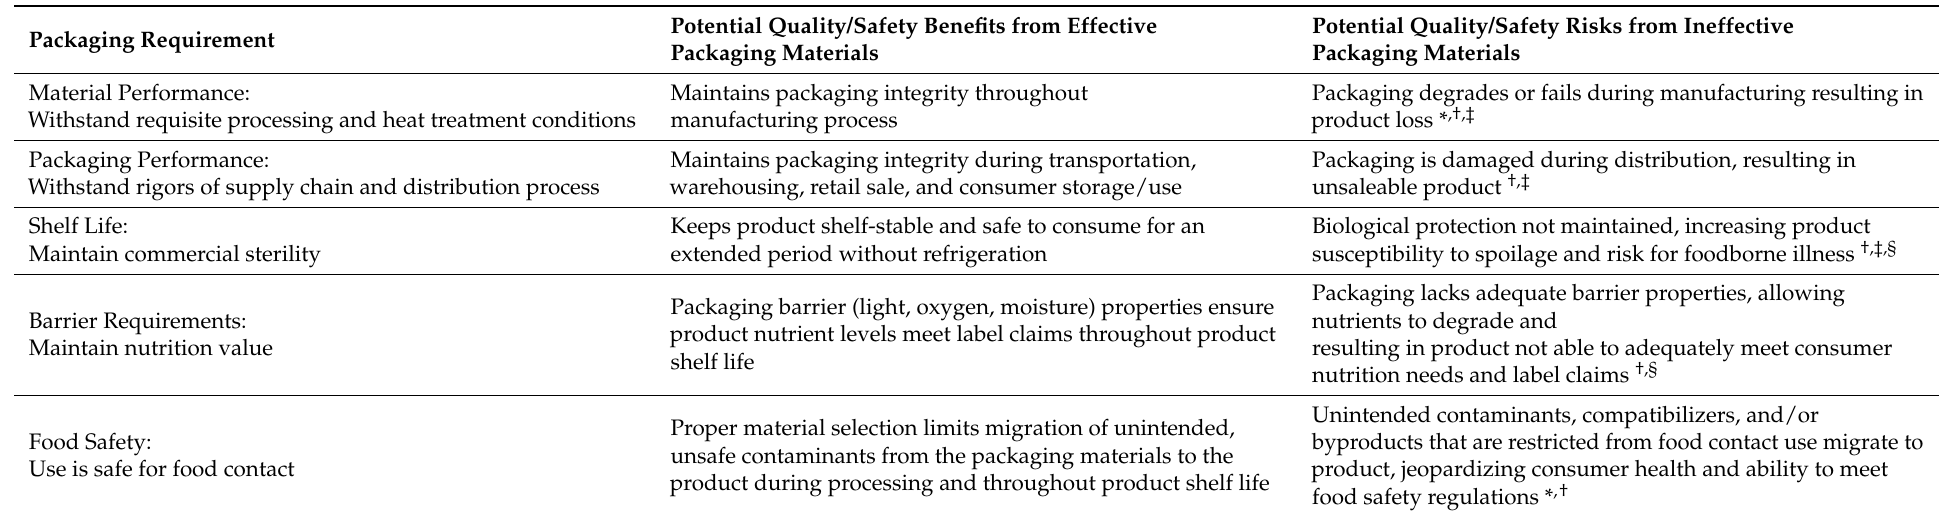
Table 4. Packaging requirements and potential quality/safety benefits and risks of effective vs. ineffective packaging materials for specialized products for vulnerable